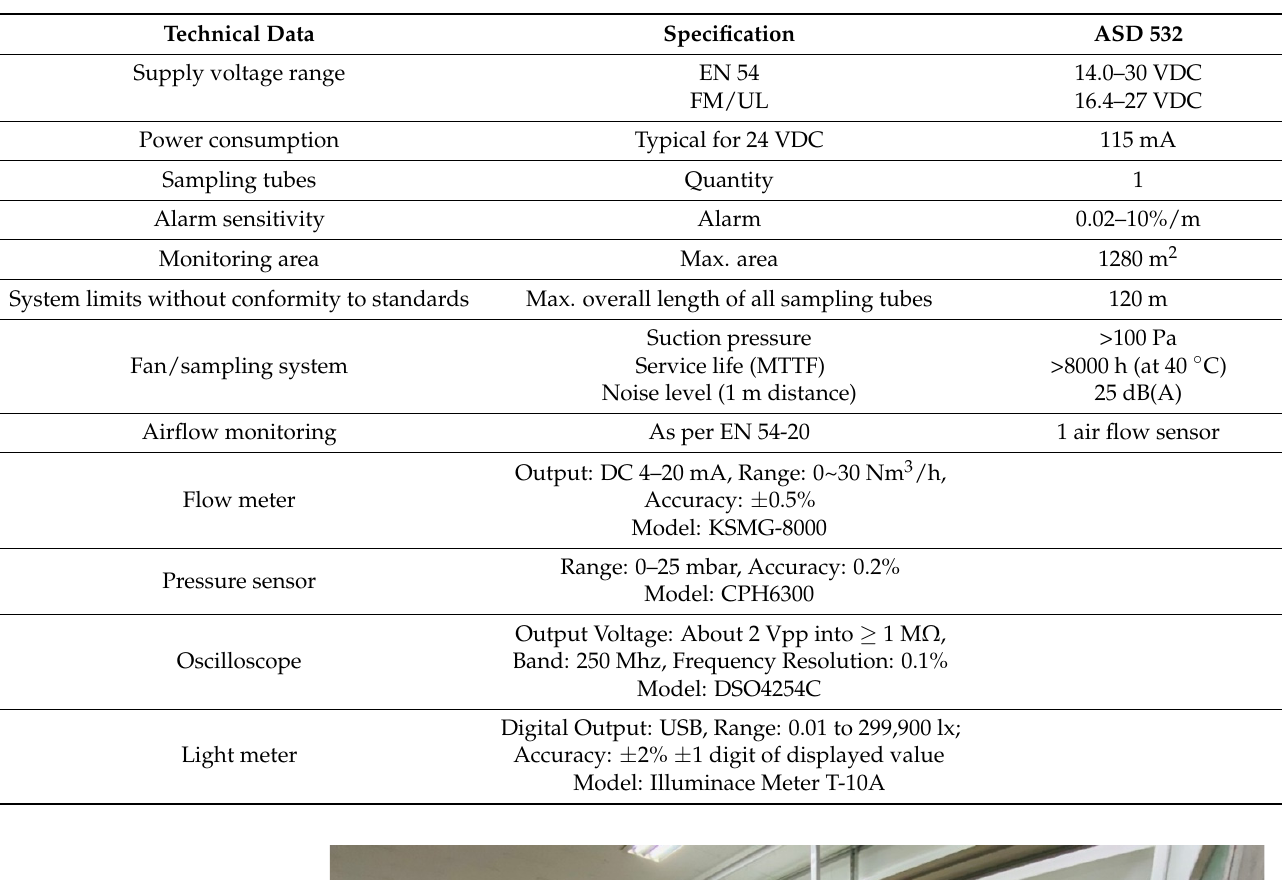
Table A1. Specification of experimental apparatus.